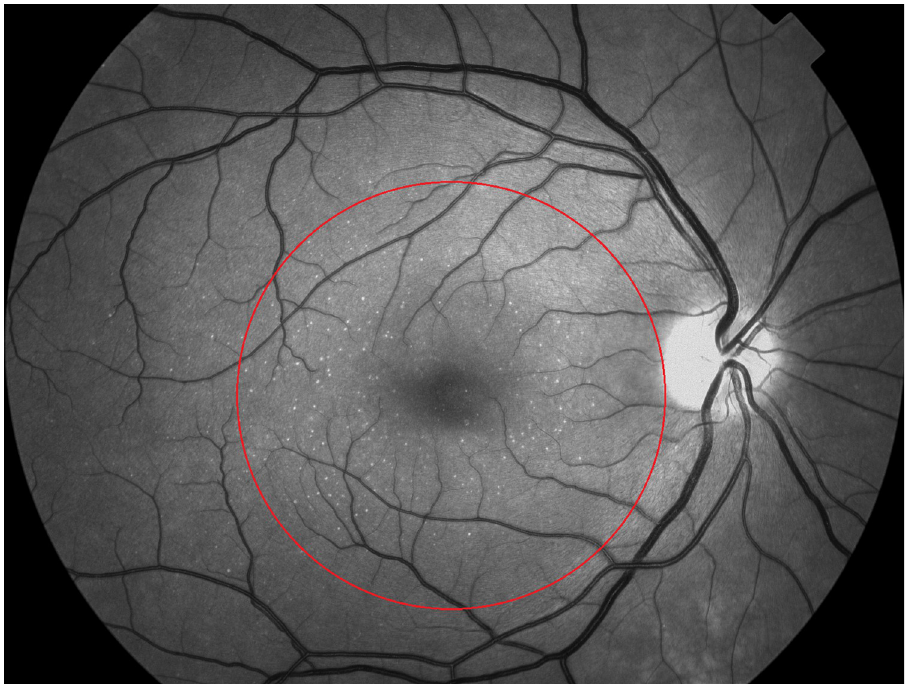
Fig 1. Circle defining the macular field. Red-free fundus photograph of a healthy eye with numerous small hard drusen inside and outside a macular annotation field marked by a red circle.